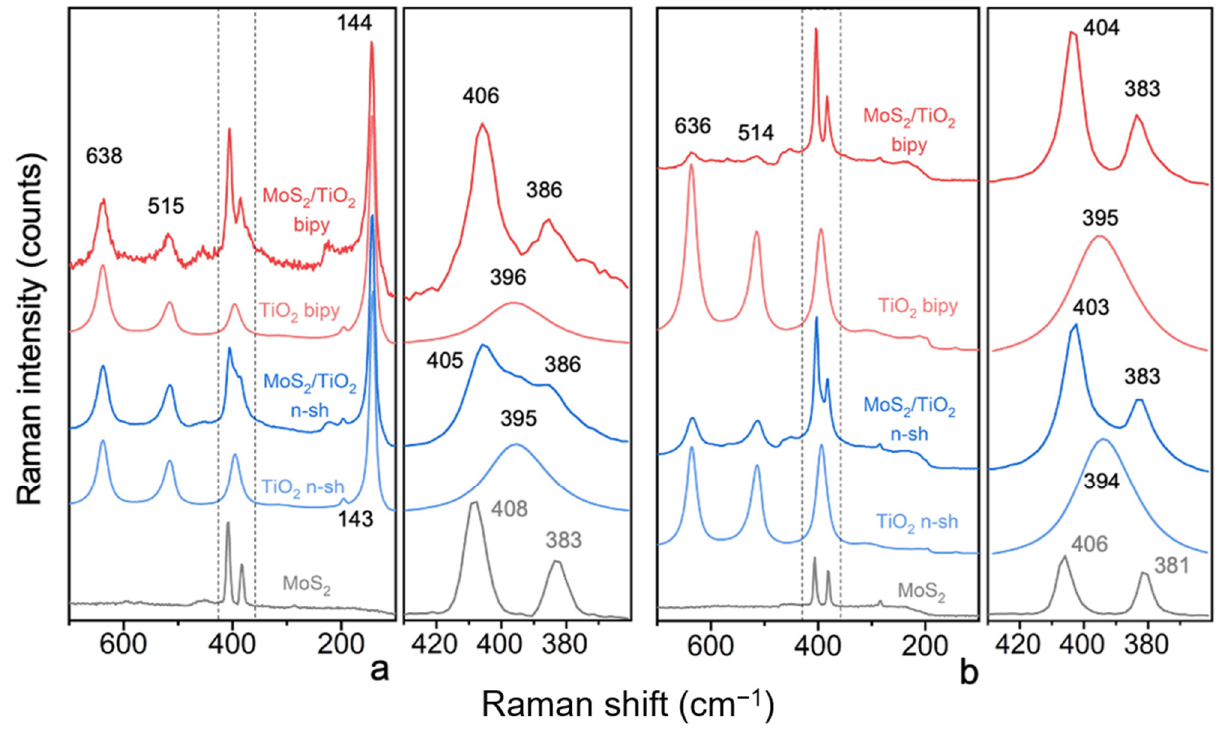
Figure 4. Raman spectra recorded with: ( a ) λ = 514 nm and ( b ) λ = 442 nm laser lines of: MoS 2 /TiO 2 bipy (red line), TiO 2 bipy (light red line), MoS 2 /TiO 2 n-sh (blue line), TiO 2 n-sh (light blue line), and bare MoS 2 (grey line) used as a reference material. Enlarged views in the 430–360 cm − 1 range have been reported on the right sides of both a and b panels.